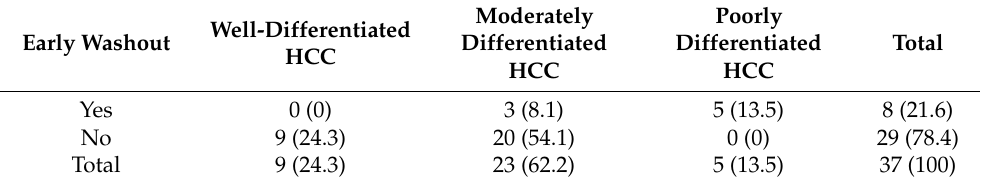
Table 8. Correlation between early washout and hepatocellular carcinoma